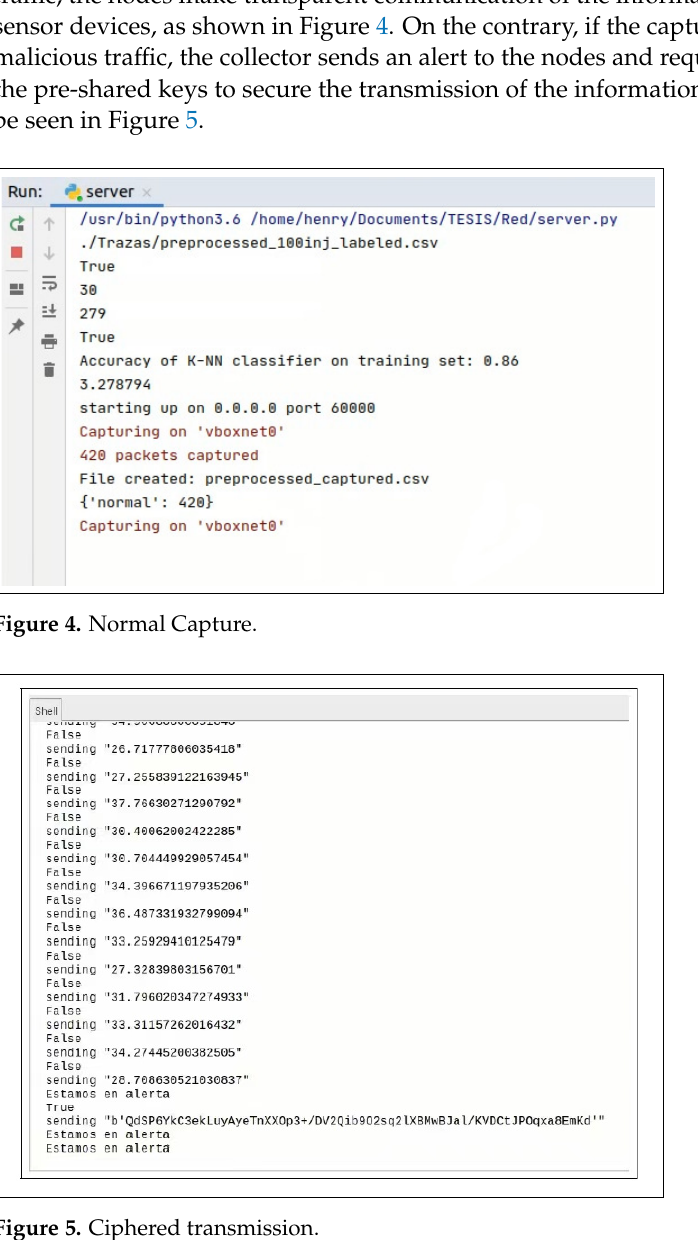
Figure 5. Ciphered